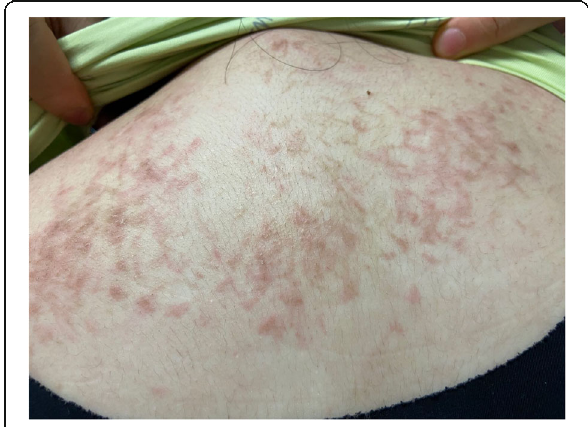
Fig. 1 Pruritus and painless rash developed on the back and shoulder skin of the